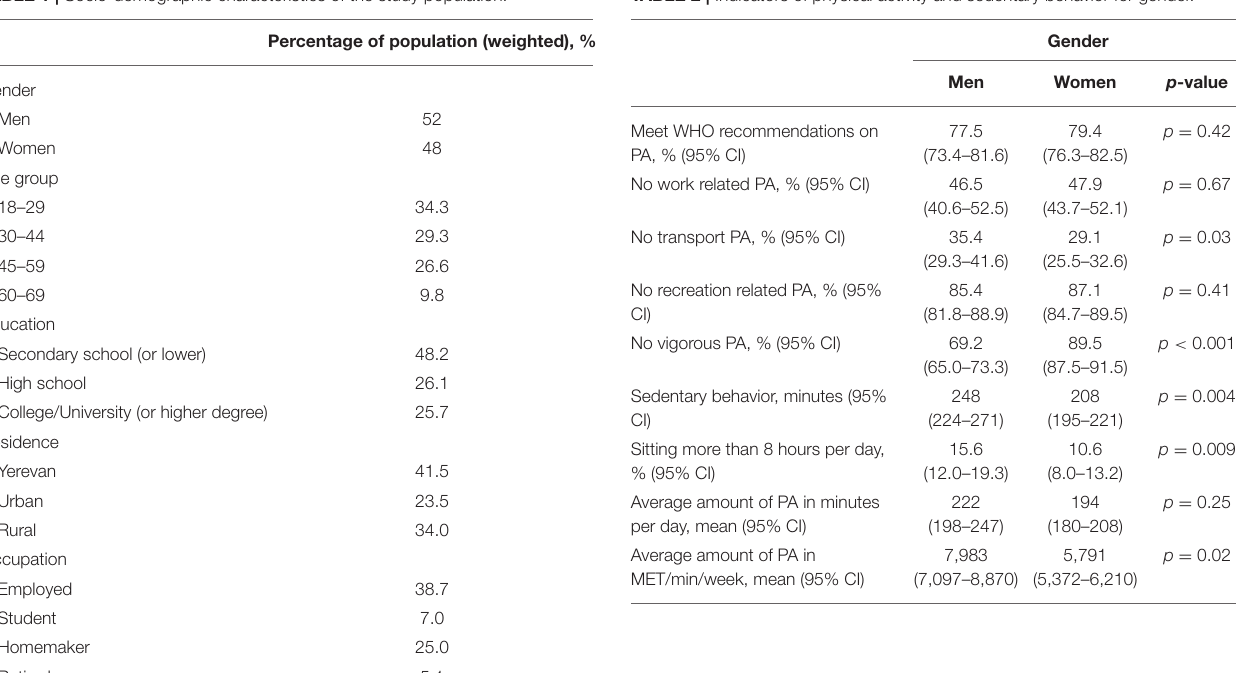
TABLE 1 | Socio-demographic characteristics of the study population. TABLE 2 | Indicators of physical activity and sedentary behavior for